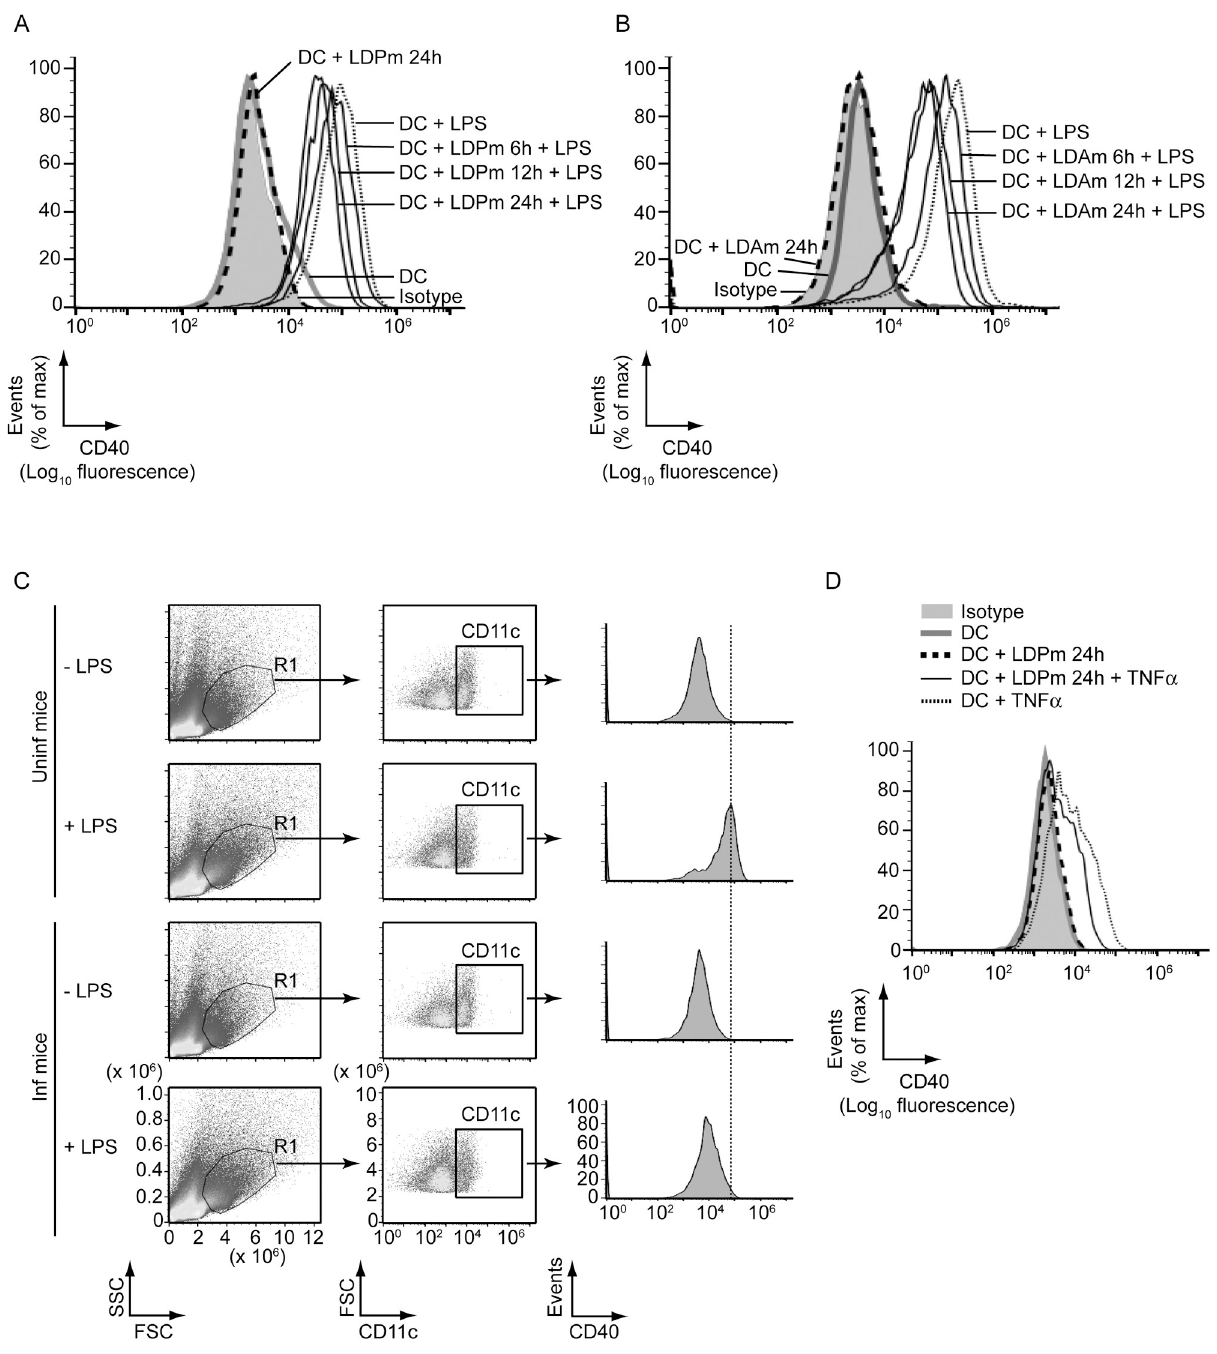
Fig 1. LD inhibits LPS- and TNF α -stimulated CD40 upregulation on DCs. (A and B) Expression of CD40 on BMDCs left uninfected (DC) or infected with LD promastigotes (LDPm; A) or amastigotes (LDAm; B) for indicated times and then stimulated with LPS for 24 h; evaluated by flow cytometry. Isotype represents immunostaining with an isotype-matched control antibody. (C) Splenocytes from uninfected (Uninf) and LD-infected (Inf) mice were cultured (at 45 days postinfection) in the presence or absence of LPS for 24 h. CD40 expression on DCs (CD11c + gated cells outlined in the middle panels) was analyzed by flow cytometry. (D) Flow cytometry analysis of CD40 expression by BMDCs left uninfected or infected for 24 h with LDPm and then stimulated with TNF α for 24 h. In all experiments, LD strain AG83 was used. Data are representative of three independent experiments. For (A), (B) and (D), the relative mean fluorescence intensity (MFI) values of CD40 expression pooled from three independent experiments are shown in S1 Fig.